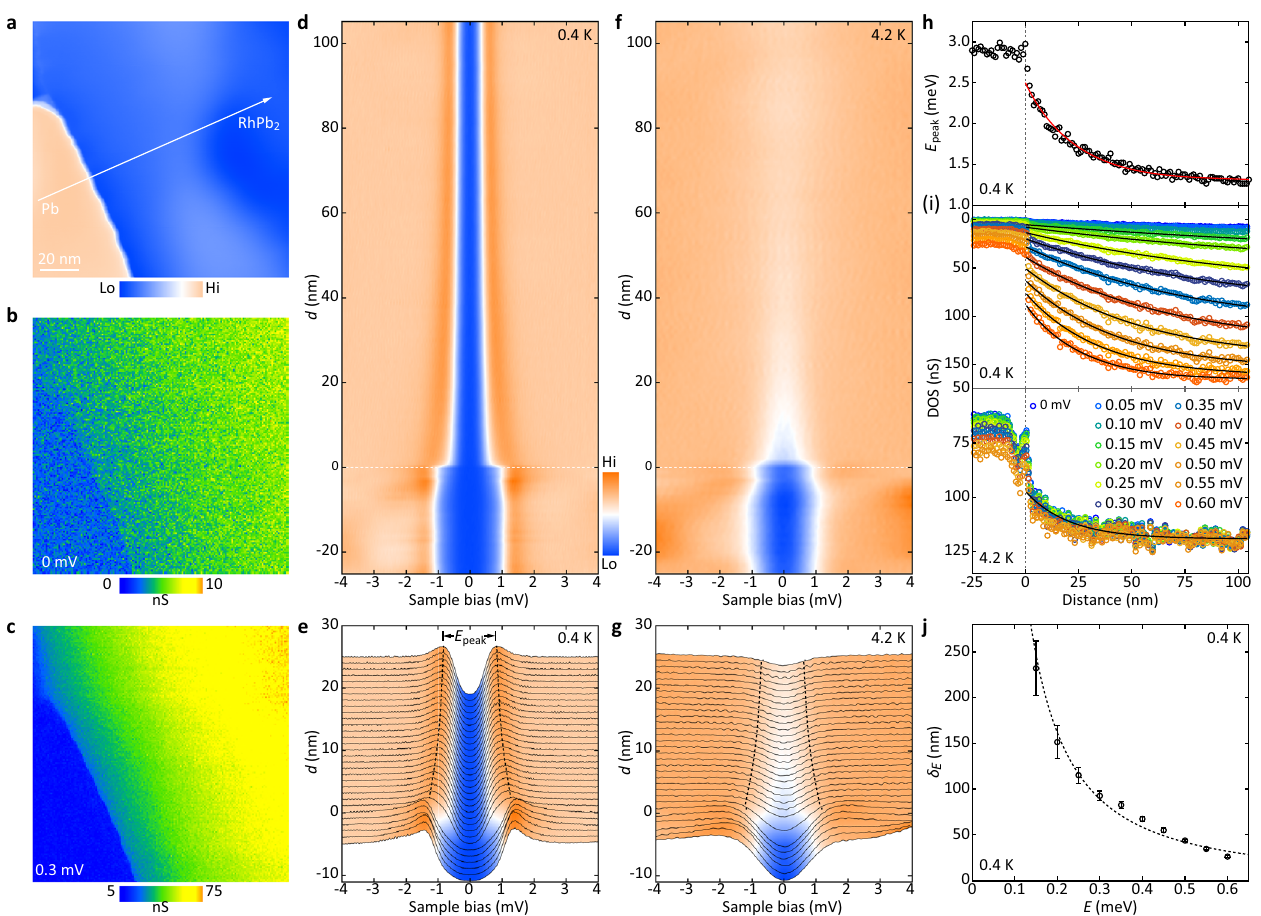
Fig. 3 Spatially resolved proximity effect. a STM topography (130 nm × 130 nm, V = 90 mV, I = 10 pA) of another Pb-RhPb 2 planar heterojunction, with the Pb island slightly higher (7 Å) than RhPb 2 . b , c Differential conductance d I /d V maps recorded simultaneously with image ( a ) at energies of zero and 0.3 meV, respectively. d Color-coded and distance d -dependent d I /d V spectra (setpoint: V = 4 mV, I = 500 pA) measured at 0.4 K along the arrowed line (normal to the Pb/RhPb 2 heterointerface) in ( a ). The spectra are taken at equal separations (1 nm), while the white dashes denote the interface with d = 0. e 3D view of the d I /d V spectra near the very heterointerface in ( d ). The black dashed lines mark the spatial variation of coherence peaks. f , g The same data as in ( d, e ), but for 4.2 K. h Spatial evolution of E peak by measuring the energy separation between the two coherence peaks in ( d ). Red line shows the best fi t of E peak to an exponential law, yielding a decay length of ∼ 27 nm. i Spatial and energy variations of the low-lying electronic DOS within the superconducting gaps of p -RhPb 2 at 0.4 K (top panel) and 4.2 K (bottom panel), with the black curves showing the exponential fi ts. j Energy-dependent decay length δ E for the low-lying DOS in T = 0.4 K. The error bars show the standard deviations of δ p -RhPb E 2 , exhibiting a divergent increase towards zero energy at Supplementary Figs. 6e, 7f). It should be emphasized that the spatial non-splitting of ZBCP is unusual and inherent to RhPb 2 , no matter whether being in close proximity to the superconducting Pb fi lms.